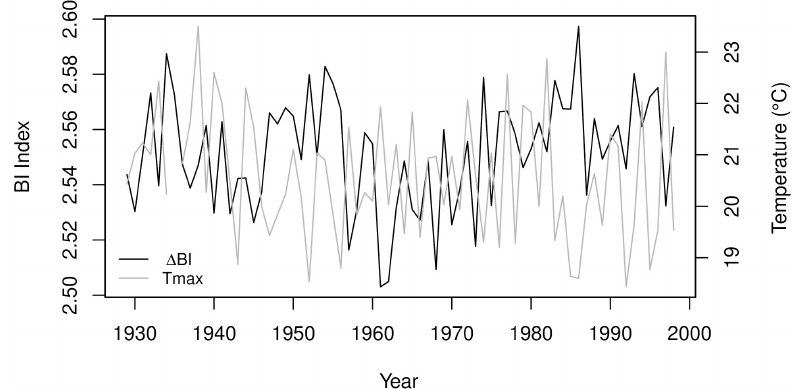
Figure A1. P. lawrencei (cid:49) BI chronology and mean October–December maximum temperature at Omeo observation station, for the 1929– 1998 period.